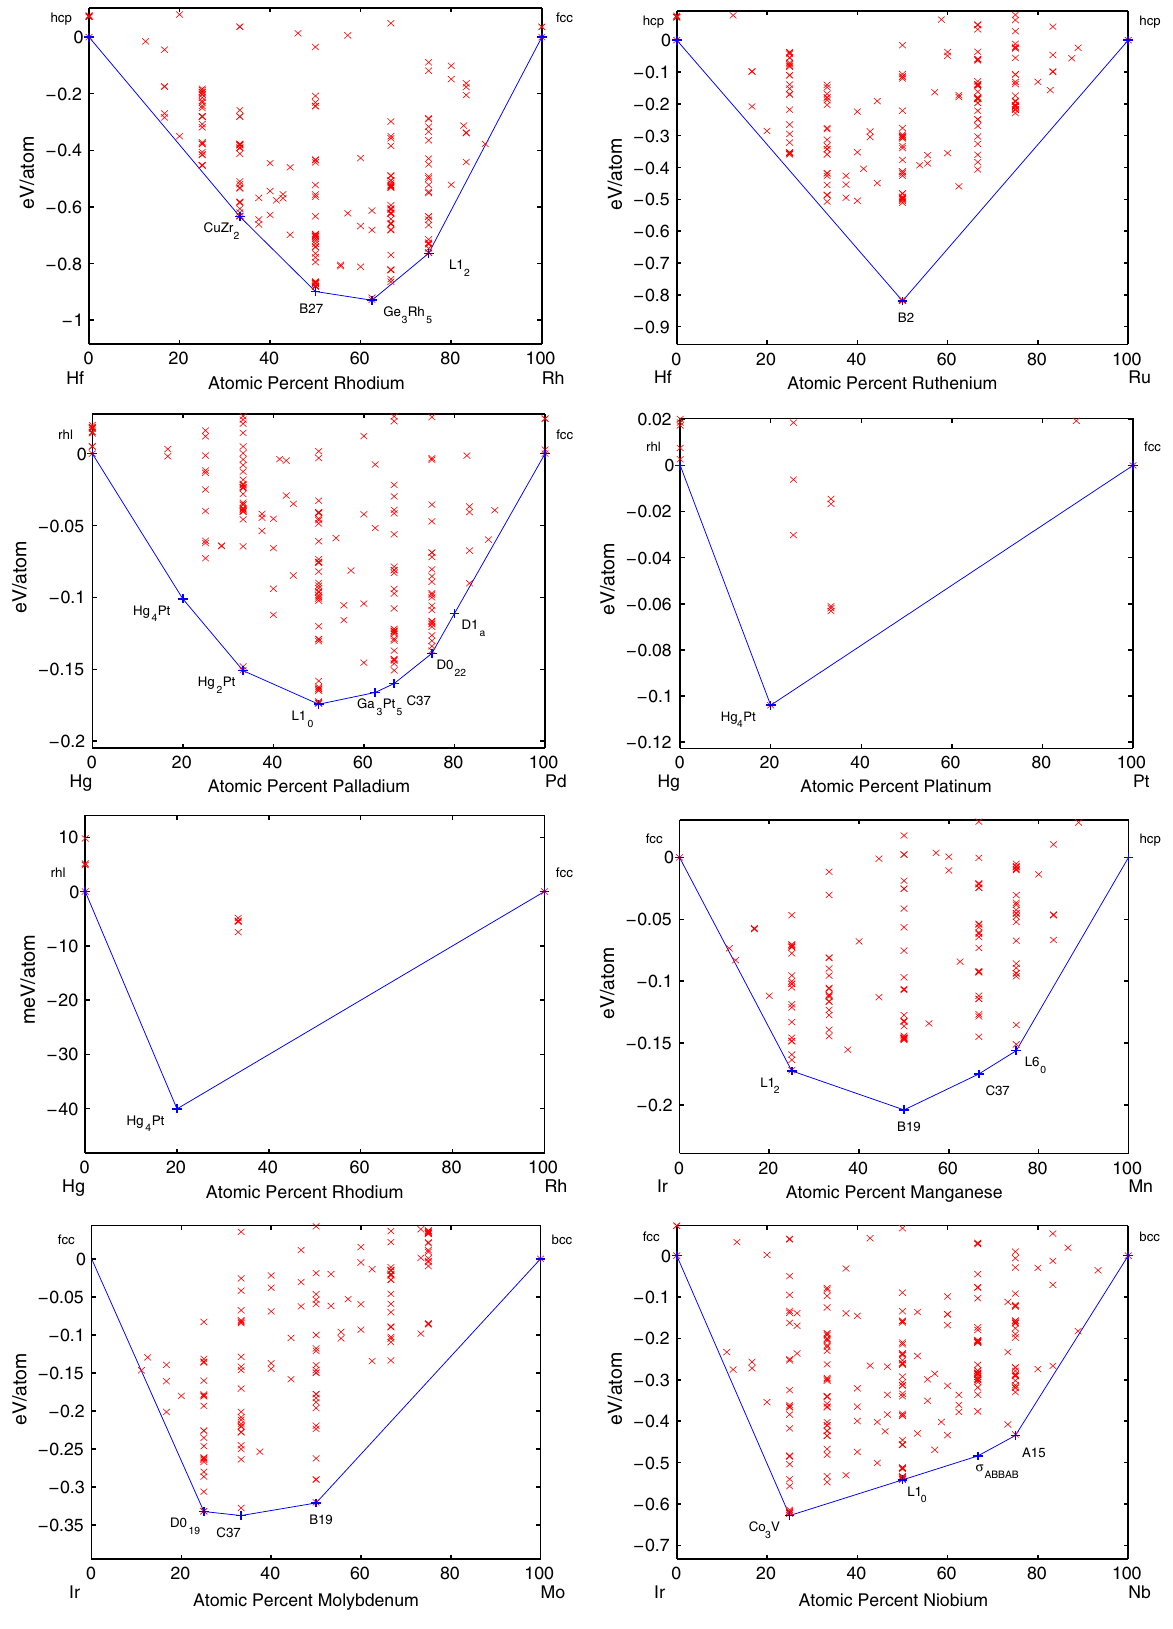
FIG. 8. Convex hulls for the systems Hf-Rh, Hf-Ru, Hg-Pd, Hg-Pt, Hg-Rh, Ir-Mn, Ir-Mo, and